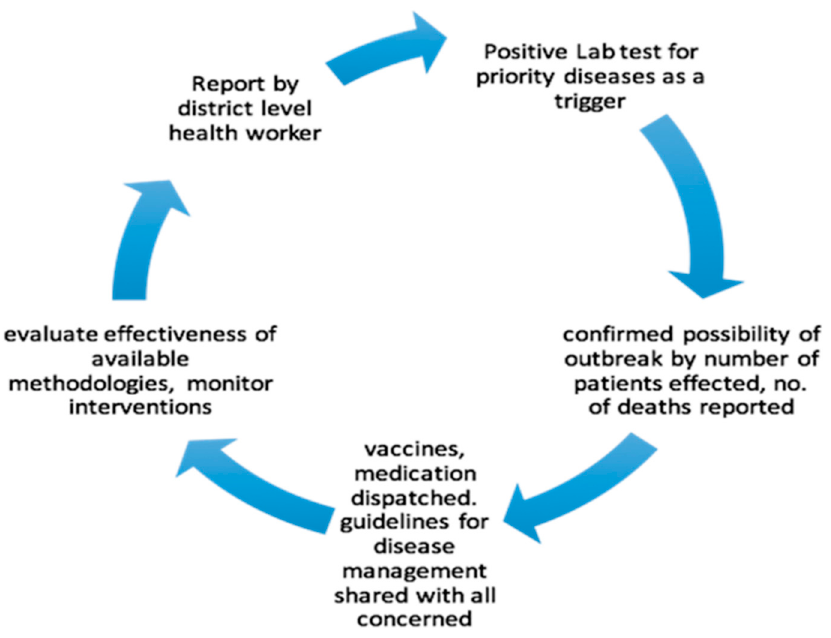
Figure 2. Sequence of events in an ideal disease surveillance systems.